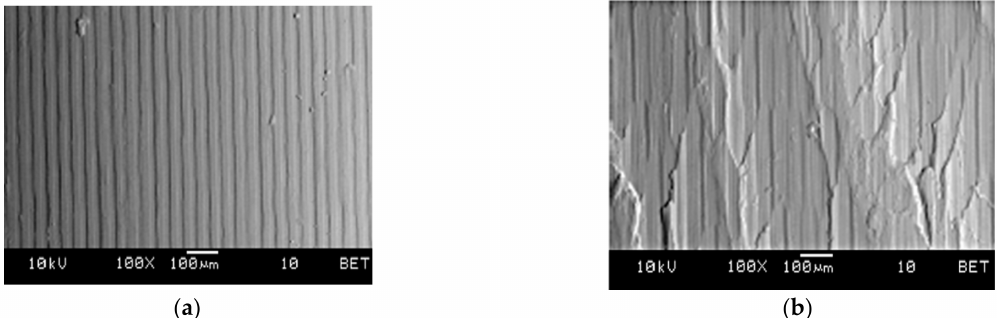
Figure 20. Microscopic image of the machined surface (cast alloy) ( a ) machining with a new tool, ( b ) machining with a worn tool VB = 0.3 mm; v c = 160 m/min, a p = 0.5 mm.